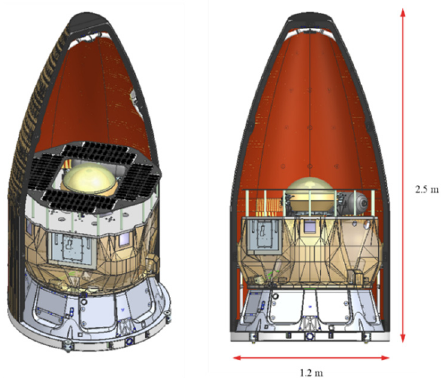
Figure 2. High-energy Photon and small Venus entry probe inside Electron’s fairing.